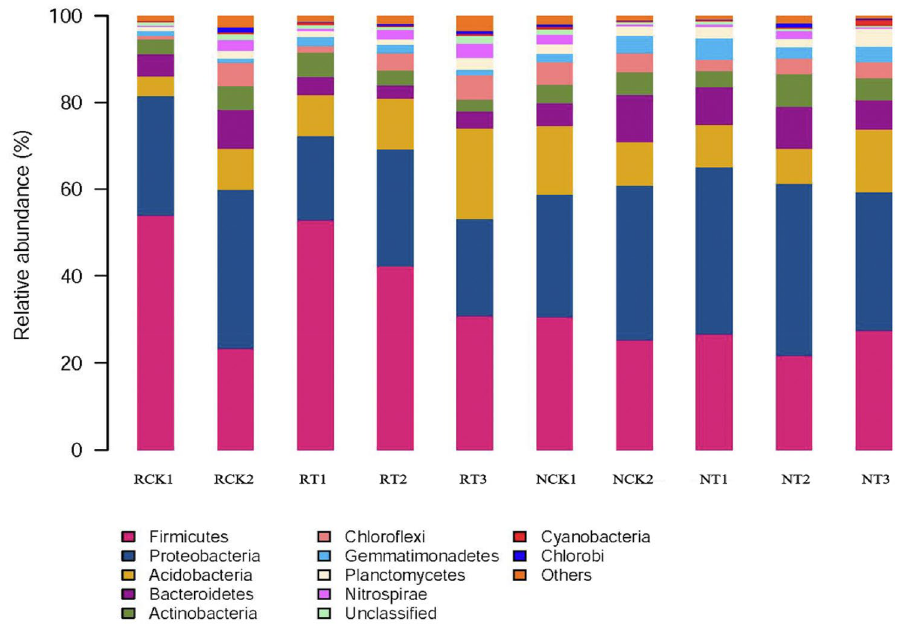
Figure 4. Relative abundance of different bacterial community structures in different treatments at the phylum level. RCK1: R-soil in CK1; RCK2: R-soil in CK2; RT1: R-soil in T1; RT2: R-soil in T2; RT3: R-soil in T3; NCK1: N-soil in CK1; NCK2: N-soil in CK2; NT1: N-soil in T1; NT2: N-soil in T2; NT3: N-soil in T3; N-soil: non- rhizosphere soil (N-soil); R-soil: rhizosphere soil (R-soil); CK1: without fertilizer and biochar addition; CK2: with fertilizer addition and without biochar; T1: fertilizer + 0.2% biochar addition; T2 treatment: fertilizer + 1.0% biochar addition; and T3: fertilizer + 5.0% biochar